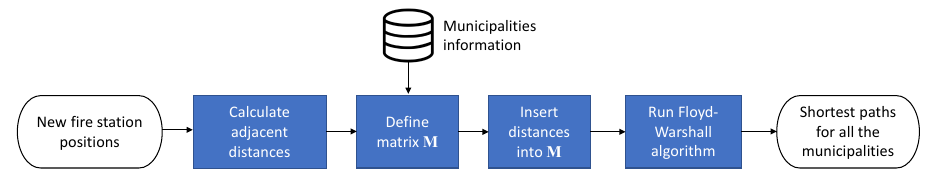
Figure 5. Block diagram of the proposed approach for shortest path